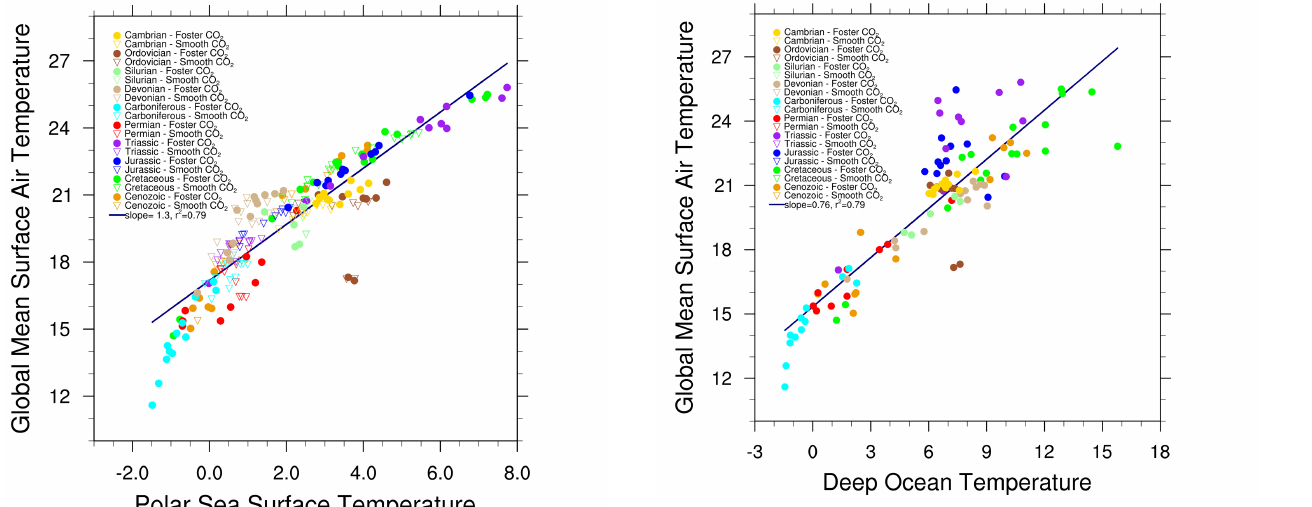
Figure 10. Correlation between high-latitude ocean temperatures (polewards of 60 ◦ ) and the annual mean, global mean surface air temperature. The polar temperatures are the average of the two win- ter hemispheres (i.e. northern DJF and southern JJA). Other details are as in Fig. 6.